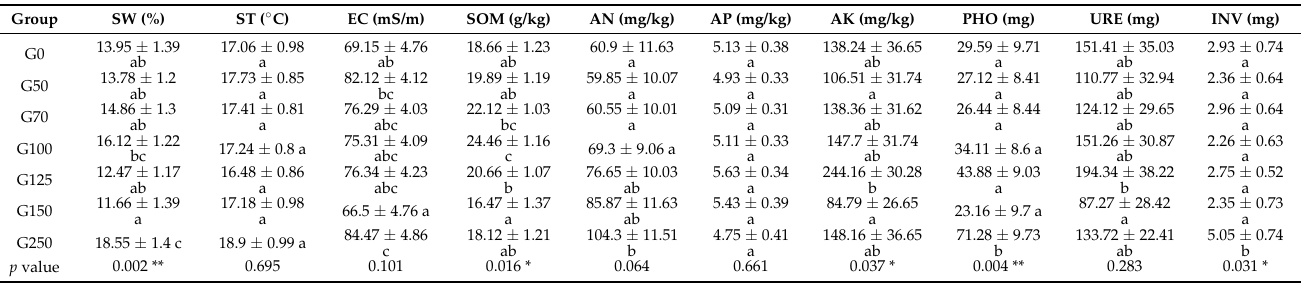
Table 3. Soil physicochemical properties of forest gaps and closed forests (Data are mean ± standard deviation (n =